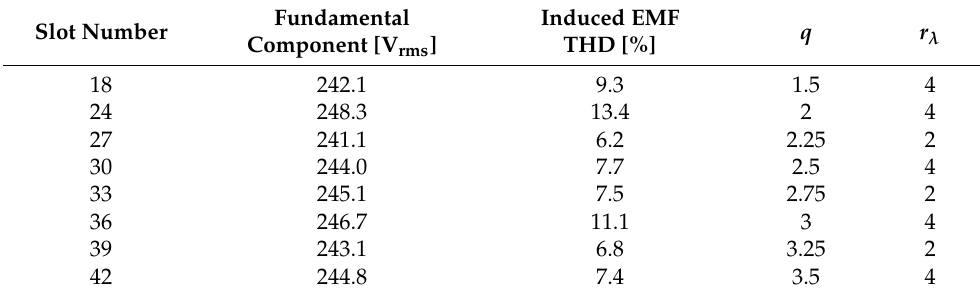
Table 2. Phase induced EMF and radial force order according to the slot number.